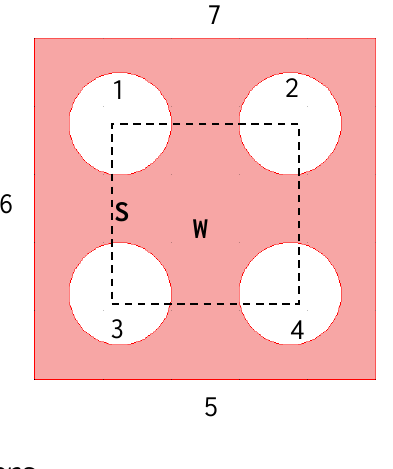
Figure 3. The computational domain, 1–4 internal boundaries, 5–8 external boundries, S—Stronger confinement region, W—Weaker confinement